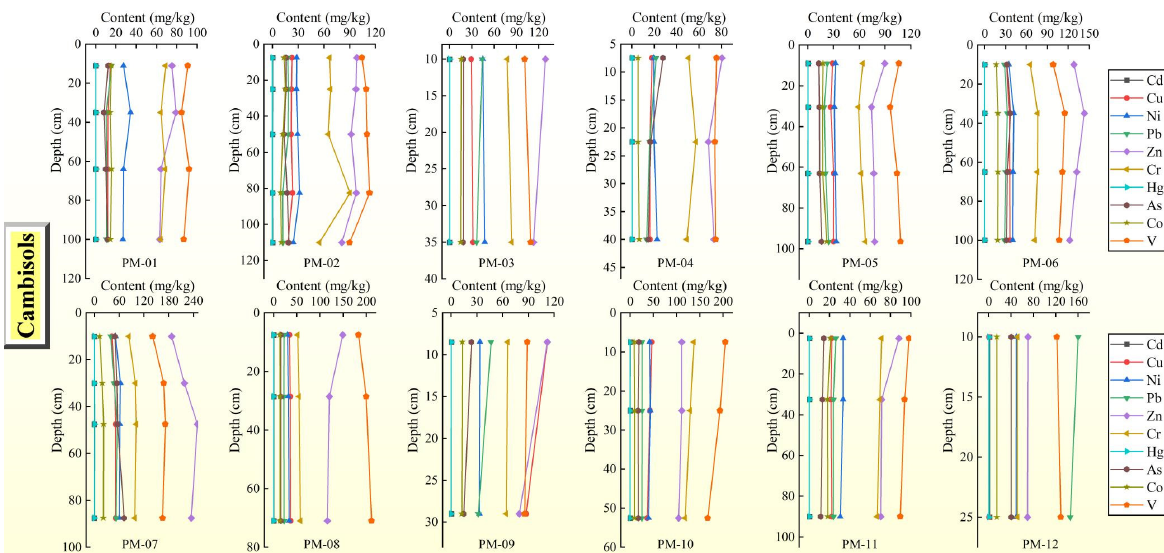
Figure 6. Distributions of HMs (Cd, Hg, Cu, Ni, Pb, Zn, Cr, As, Co, and V) in the Cambisols profile ( N = 12).